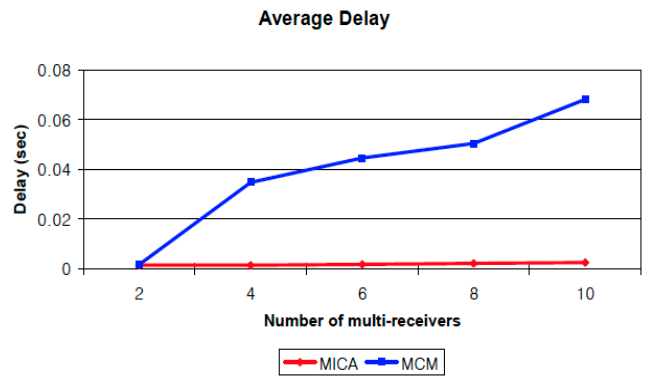
Figure 7. Comparison of end-to-end packet delay.